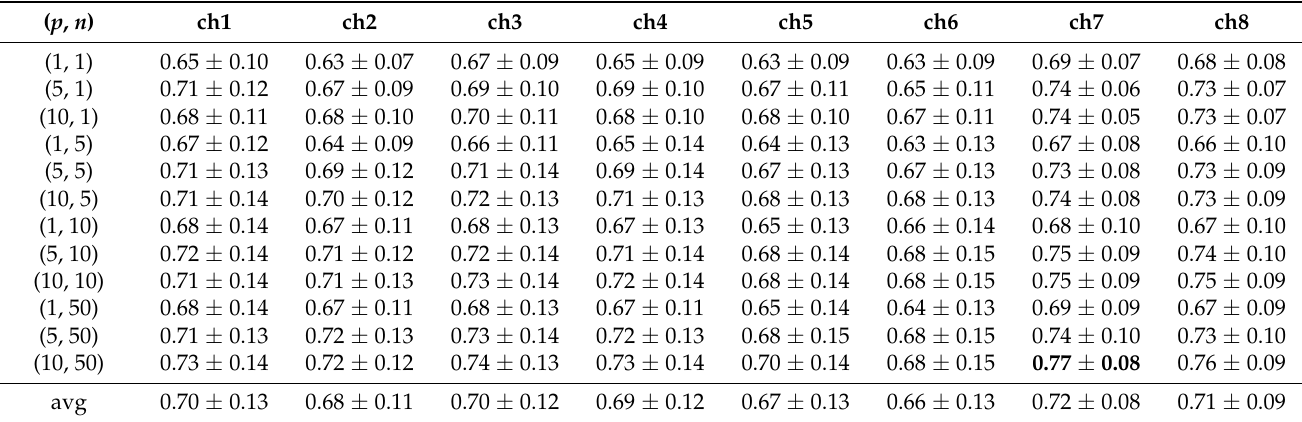
Table 3. A3S-Rec dataset: AUPRC of the 10-way 10-shot US8K prototypical model tested on individual recordings for each acquisition sensor.